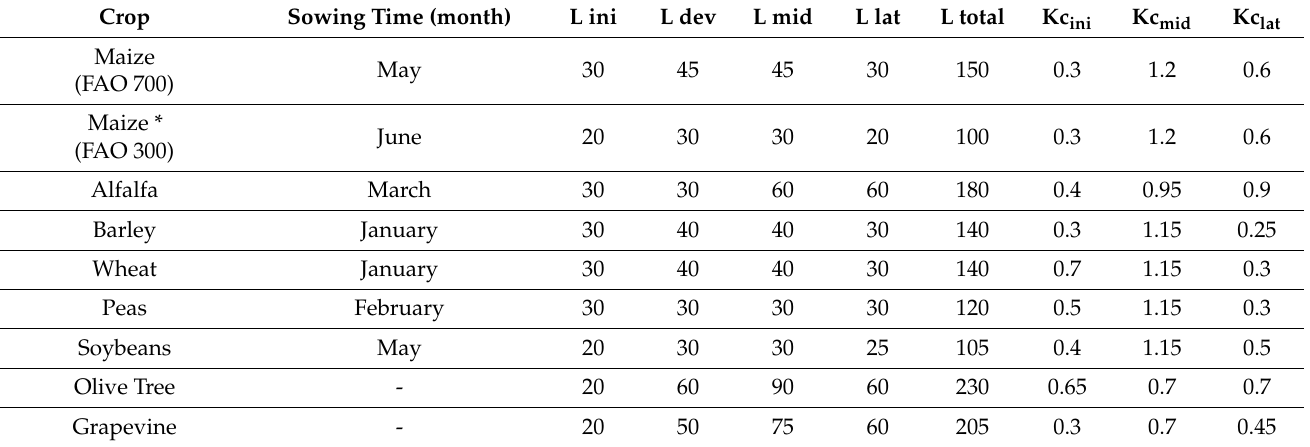
Table 3. Sowing time, lengths of the four distinct growth stages and the growing total in days: initial (L ini ), development (L dev ), middle (L mid ), late (L lat ) and total (L total). Crop coefficients for the initial stage (Kc ini ), for the mid-season stage (Kc mid ) and for the end of late season stage (Kc lat ) [4]. The sowing dates and the lengths of development were adapted to the Algerri-Balaguer irrigation district characteristics. * Maize FAO 300 is sowed as a secondary crop immediately after barley, wheat or